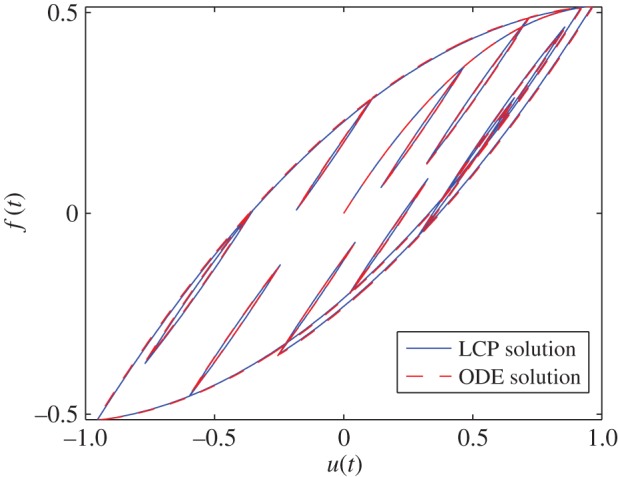
Hysteresis curves obtained for a 50 dimensional system from LCP and ODE solutions.